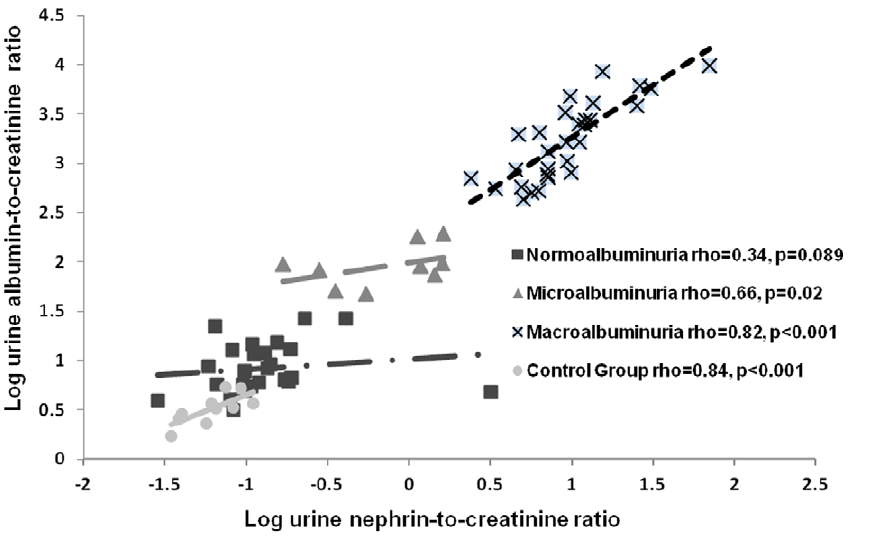
Figure 2. Correlations between urine nephrin-to-creatinine ratio (UNCR) and clinical markers of renal disease. A) Log transformed UNCR correlates significantly with macroalbuminuria ( rho =0.82, p , 0.0001) and microalbuminuria ( rho =0.66, p=0,02), and not significantly with normoalbuminuria ( rho =0.34, p=0.09) when divided into groups according to level of albuminuria. doi:10.1371/journal.pone.0036041.g002 PLoS ONE |